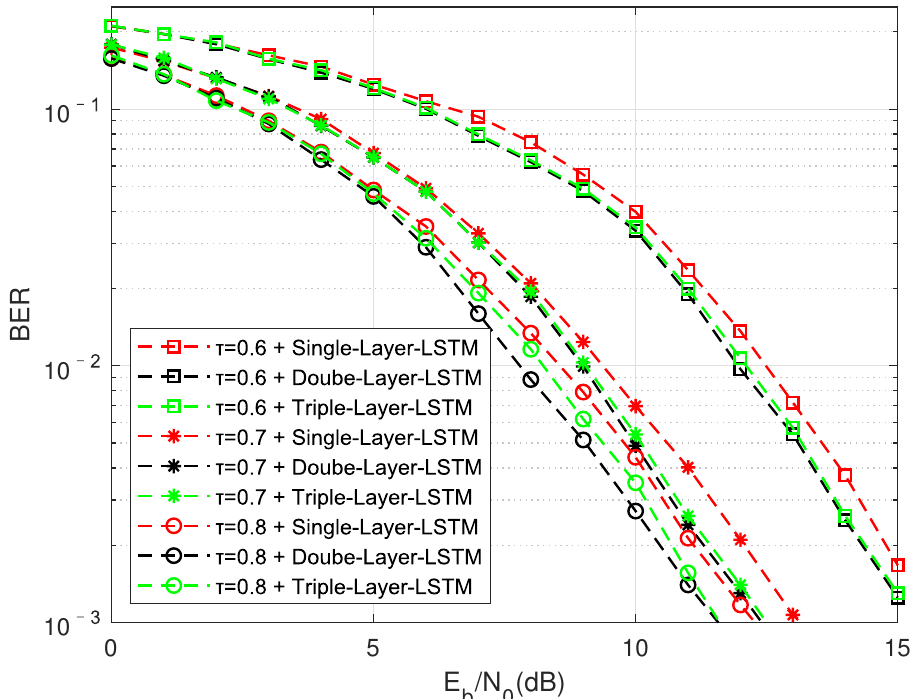
Figure 12. Under the TU channel moving speed of 60 km/h, compare the impact of the number of LSTM networkayers on performance.